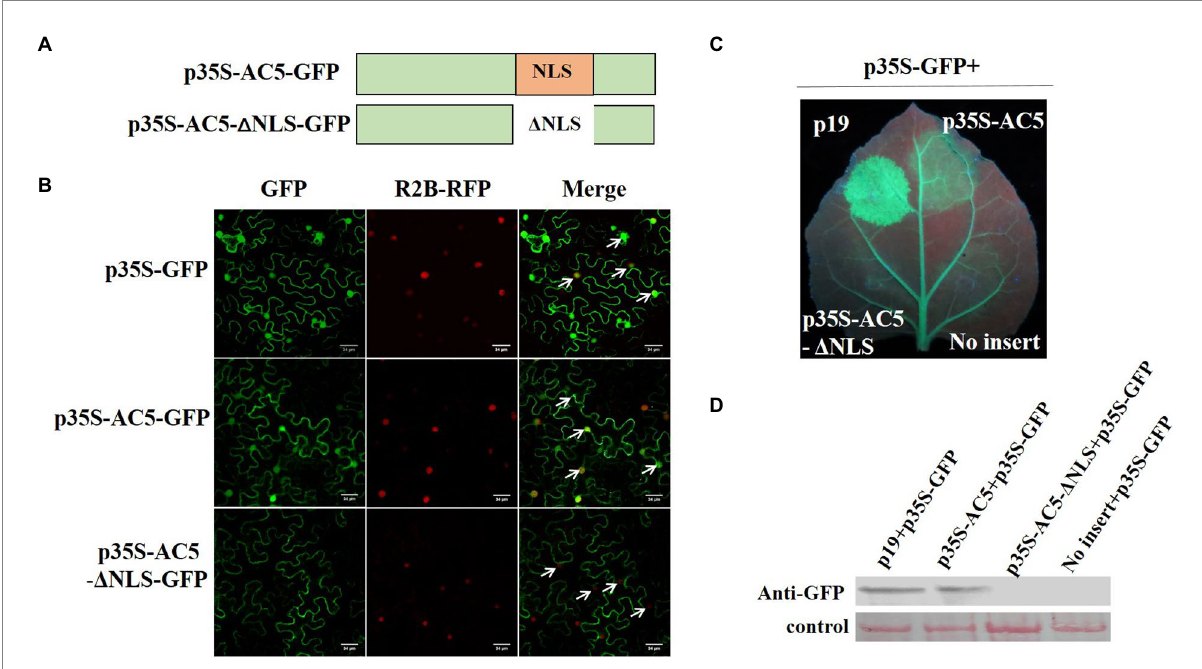
FIGURE 6 Analysis of the subcellular localization of SLCCNV AC5, the AC5 nuclear localization signal (NLS), and PTGS. (A) Schematic representation of SLCCNV AC5 and a deletion mutant of its NLS. (B) Cellular and subcellular localization of SLCCNV AC5 and its derivatives in cells. H 2 B-RFP represents RFP fused at the C-terminus of the nuclear marker histone 2B. The white arrows indicate the nuclei. Scale bar = 34 μ m. (C) Suppression of GFP silencing in GFP-transgenic 16c plants. Leaf patches were co-infiltrated with A . tumefaciens cultures harboring p35S-GFP + p19,